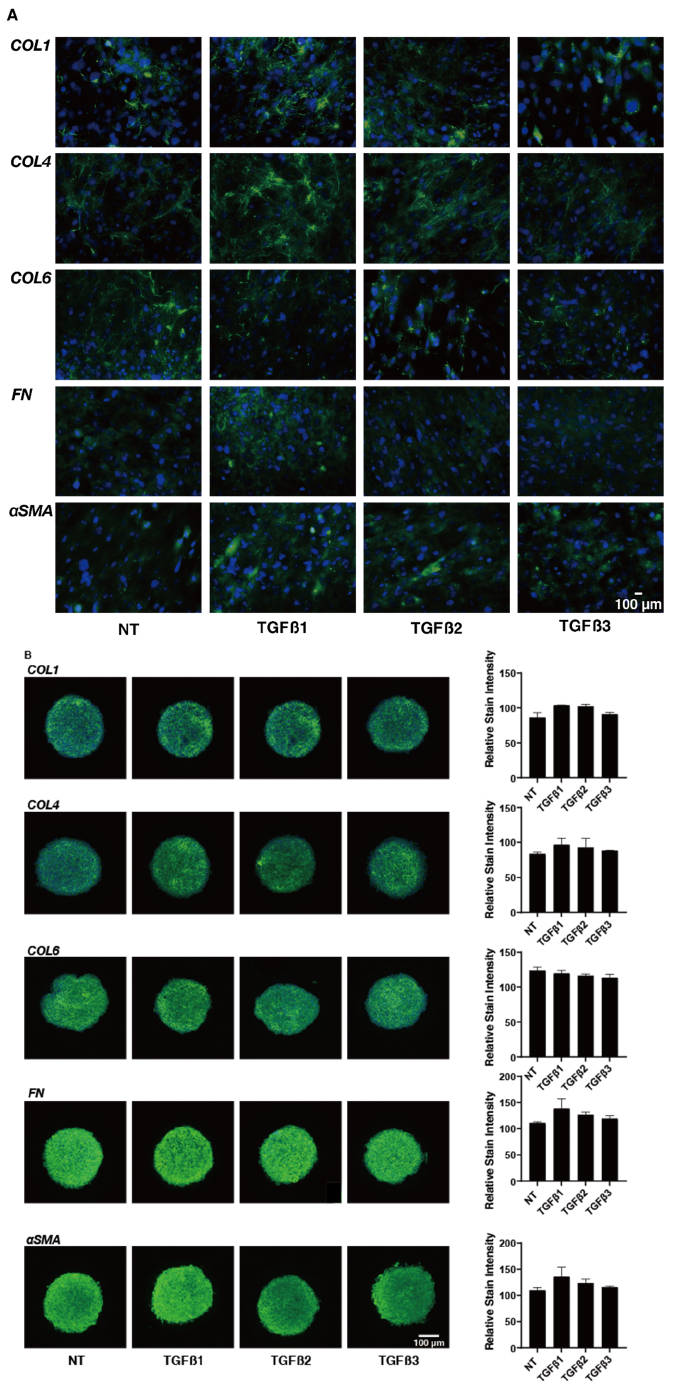
Figure 5. Effects of TGF- β isoforms on immunolabeling against ECM molecules in 2D- and 3D- cultured HTM cells. At day 6, 2D- and 3D-cultured HTM cells (NT, non-treated control) and cultures treated with 10 ng/mL TGF- β -1, 5 ng/mL TGF- β -2, or 1 ng/mL TGF- β -3 were subjected to im- munofluorescent labeling of ECMs ( COL1 , COL4 , COL6 , FN, and aSMA ). All experiments were performed in duplicate using fresh preparations (n = 5, total 10). Representative merged images with DAPI (blue) and ECM (green) are shown (panel ( A ) left ; 2D, panel ( B ) left ; 3D, scale bar; 100 µ m). The immunostaining levels of each target molecule among the observed areas were evaluated using Image J (NIS-Elements 4.0 software) and plotted (panel ( A ) right ; 2D, panel ( B ) right ;